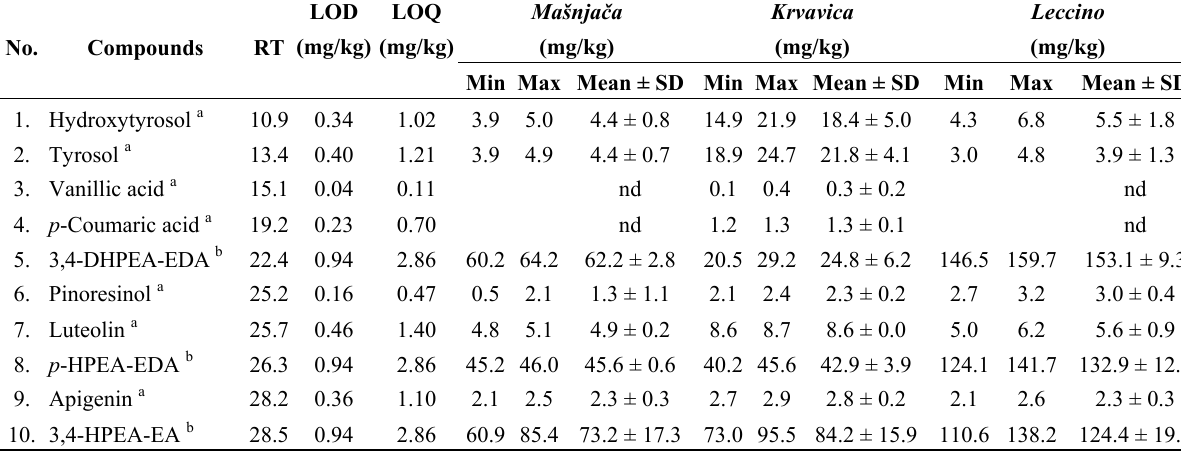
compounds; b Tentative identification by UV-Vis spectra and comparison of retention times with the literature data, and